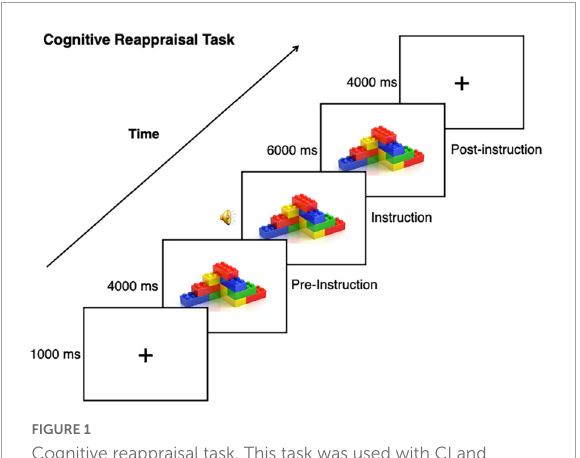
FIGURE1 Cognitive reappraisal task. This task was used with CI and nonsocial object stimuli, task instructions included prompting to either “Think Positive” or “Think Negative” about the